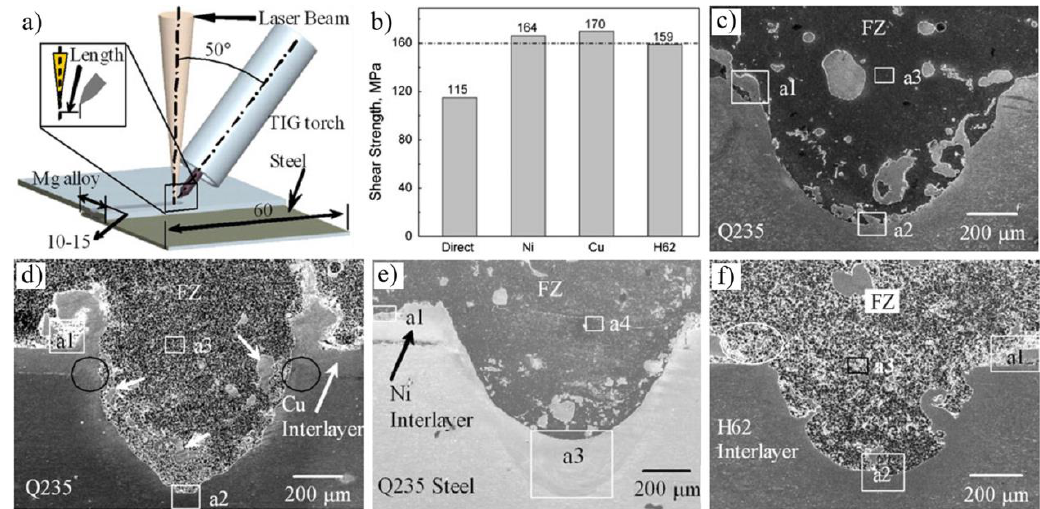
Figure 21. Laser-TIG lap welding with different interlayers [70] ( a ) schematic diagram of welding; ( b ) strength comparison of various interlayer-added joints; ( c – f ) microstructures of Mg/steel joints with no Cu, Ni, Cu-Zn interlayer.